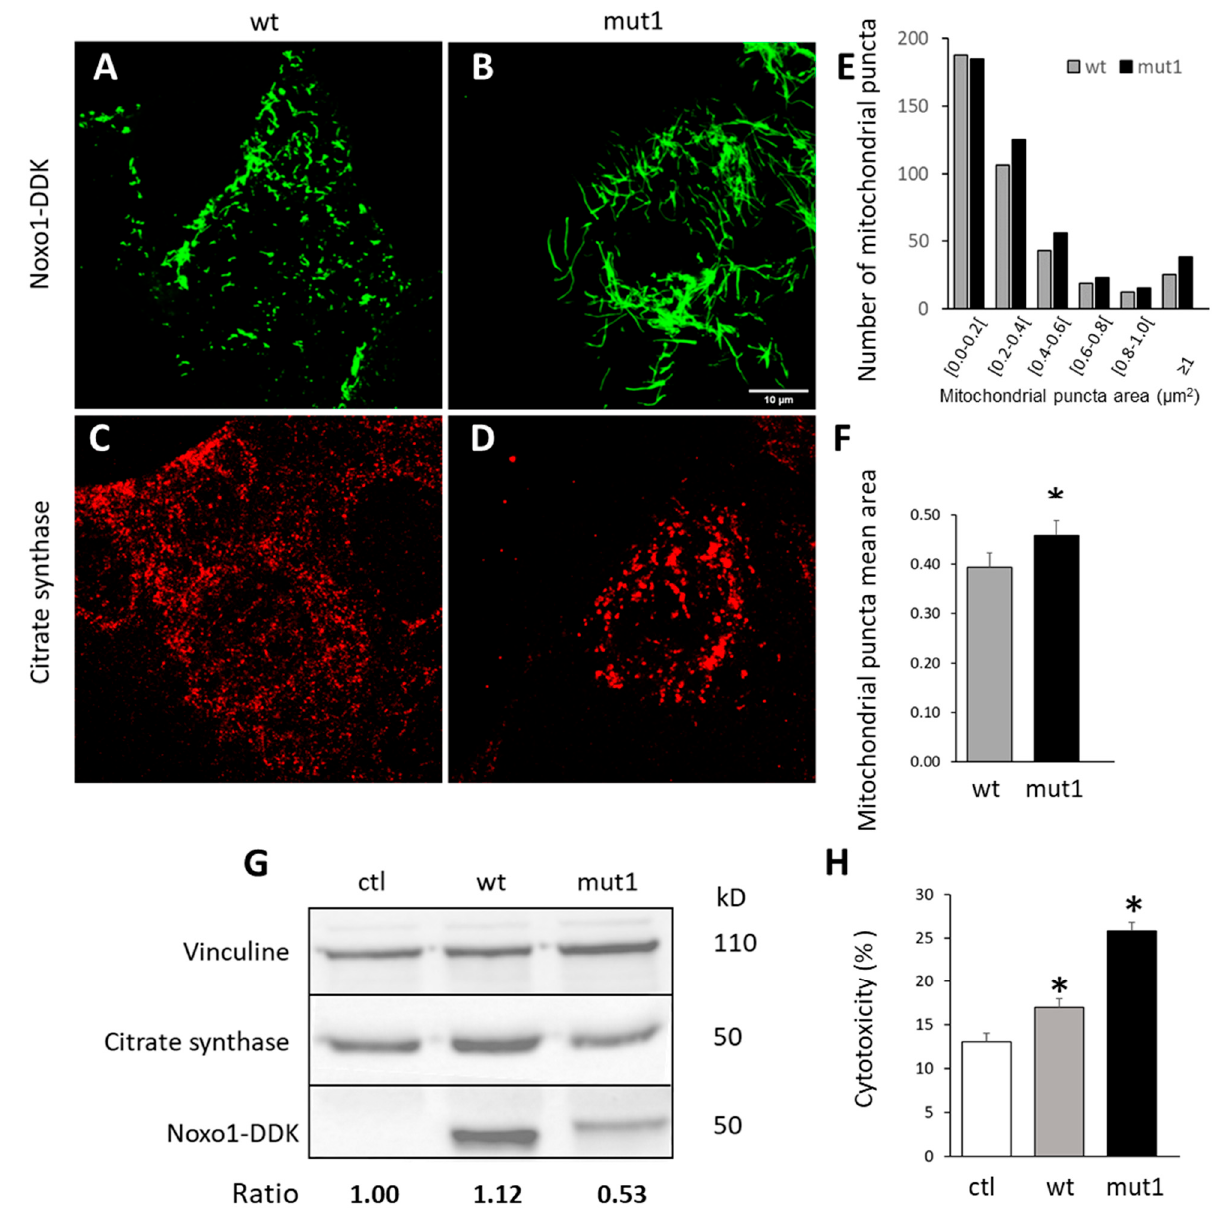
Figure 4. Mut1 Noxo1-DDK overexpression affects the mitochondrial organization and cellular toxicity in Caco-2 cells. Mitochondria were revealed using antibodies directed against the specific mitochondrial enzyme citrate synthase ( A , C ) in wt and mut1 Noxo1-DDK expressing cells ( B , D ). Scale bar in all panels: 10 µ m. ( E , F ) Quantification of the apparent mitochondrial areas were measured in wt and mut1 Noxo1-DDK expressing cells. Histograms showing the distributions of the mitochondrial puncta area classes ( E ) and the average mitochondrial puncta area in wt and mut1 Noxo1-DDK expressing cells ( F ). ( G ) Immunoblot of the total expression of citrate synthase, Noxo1, and vinculin in wt and mut1 Noxo1-DDK expressing cells. The lower numbers referred to the ratio of citrate synthase/vinculin. ( H ) Cellular toxicity assessed using blue trypan vital staining followed by cell counting in ctl, wt, and mut1 Noxo1-DDK transfected cells. Altogether, mut1 Noxo1 overexpression induced mitochondrial aggregation and cellular toxicity compared to wt Noxo1. * p < 0.05 compared to ctl.